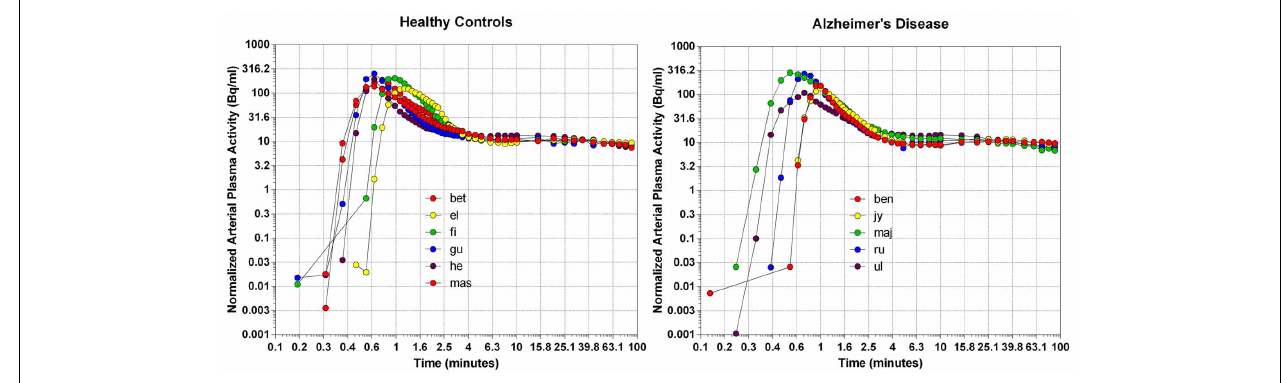
FIGURE 1 | The distributions of arterial plasma concentrations in healthy volunteers (left panel) and patients with Alzheimer’s disease (right panel), normalized to average Area